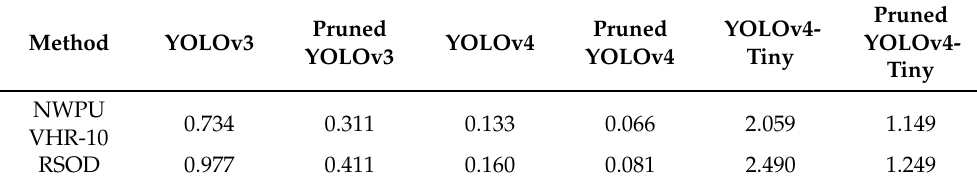
Table 7. Inference time (s) for different models on a